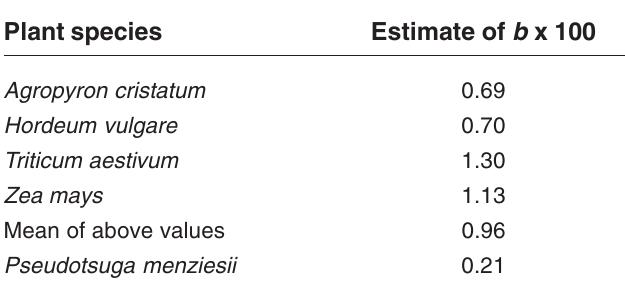
TABLE 3 Estimates of Model Parameter b of Model (2) for Some Plant Species (kg N/ha)